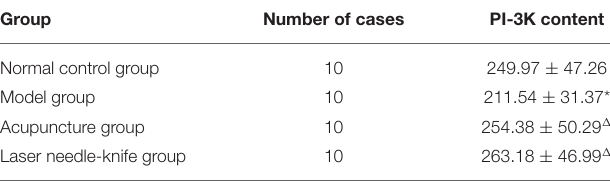
TABLE 3 | Comparison of PI-3K content in CSA Rabbits ( ¯ x ± S) (pg/mg). Group